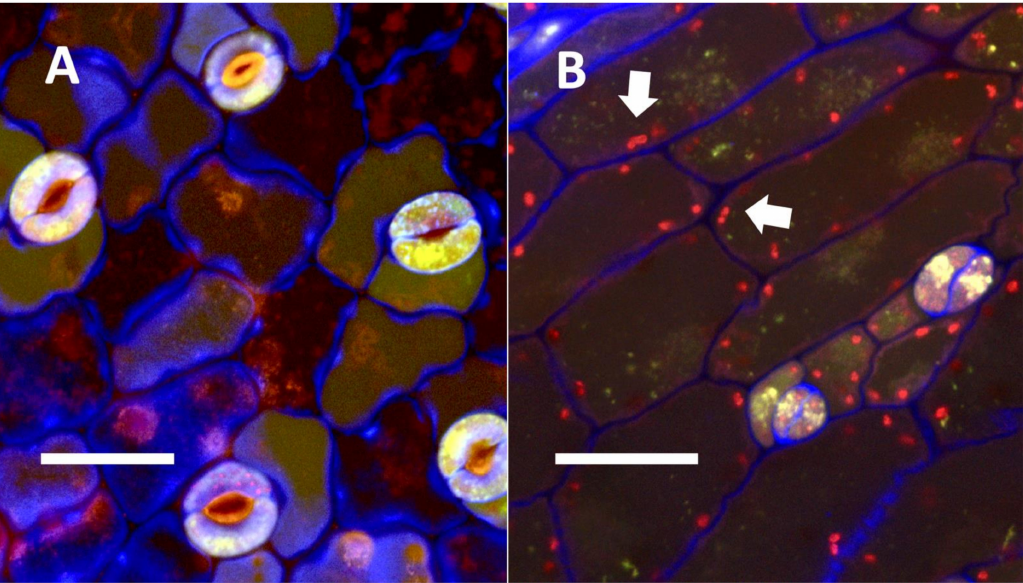
Figure 15. Confocal image of seedling leaves with and without mCherry-tagged bacteria ( Klebsiella oxytoca ) within epidermal cells. ( A ) Uninoculated control of Trifolium pratense leaf from inoculation experiment without mCherry-tagged bacteria within leaf epidermal cells (Bar = 10 µ m). ( B ) Inoculated leaf of Trifolium pratense from inoculation experiment with red mCherry-tagged bacteria (arrows) within leaf epidermal cells (Bar = 10 µ m).